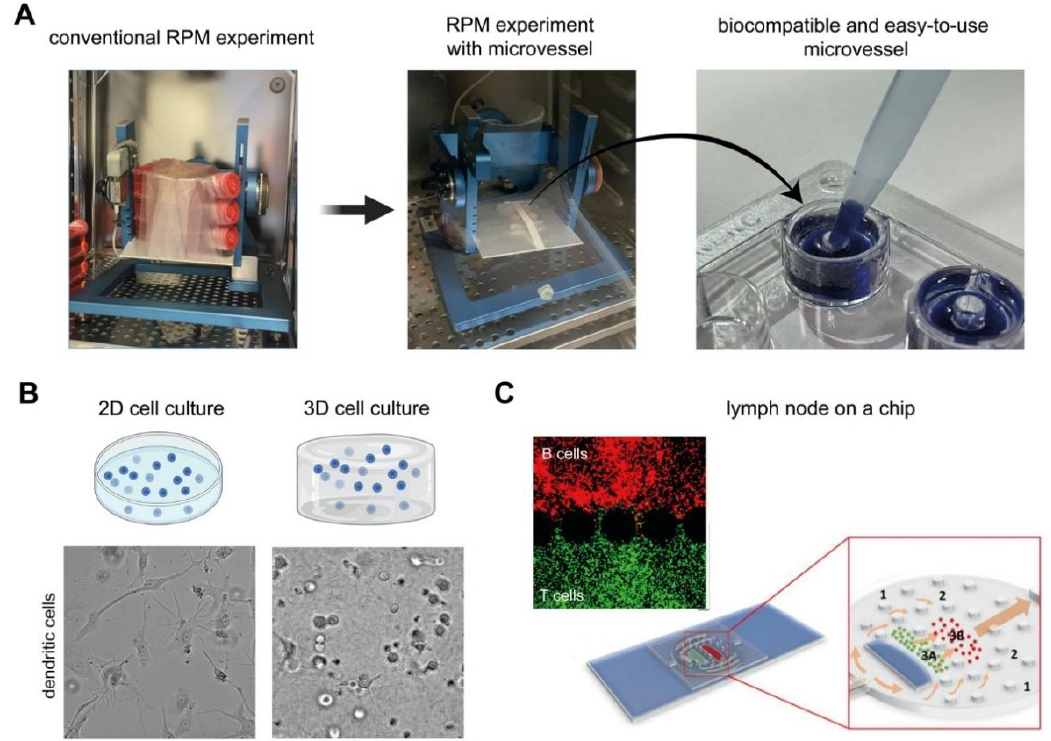
Figure 4. Cell culture techniques for improved physiological relevance in microgravity research. ( A ) Biocompatible and easy to use microvessels developed for high throughput studies [119]. ( B ) 2D and 3D biomimetic cell culture model showing more rounded cells in 3D culture compared to 2D [69]. ( C ) Organ on a chip technology by combining 3D cell culture and microfluidic systems [120].